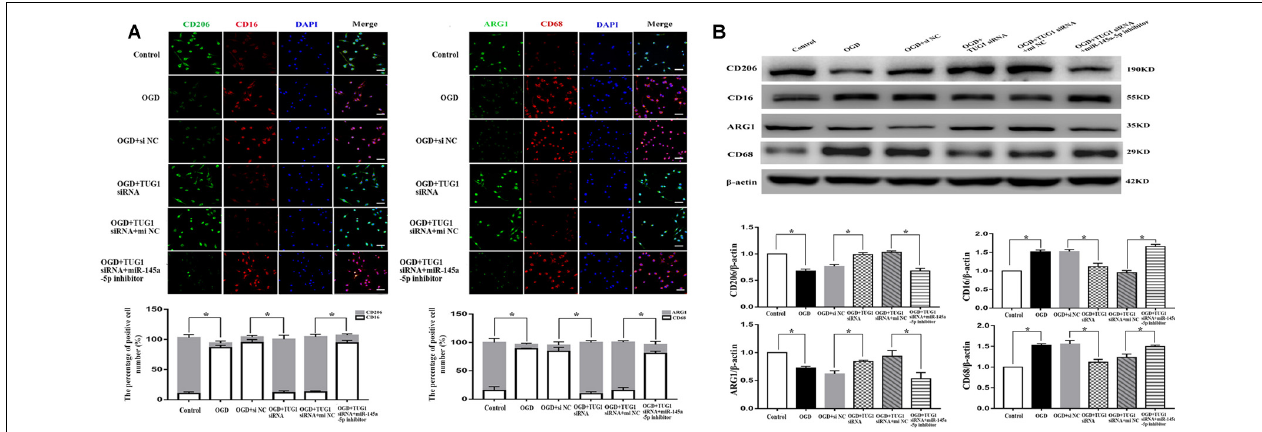
FIGURE 3 | Microglial polarization by immunofluorescence (A) and western blot (B) . TUG1 knockdown increased the number of ARG1 and CD206 positive cells (M2-like phenotype, green) as well as the protein levels, whereas decreased that of CD16 and CD68 positive cells (M1-like phenotype, red) as well as the protein levels after OGD. The effect of TUG1 knockdown on microglial polarization was reversed by miR-145a-5p inhibitor. ∗ P < 0.05 vs. the corresponding control. 400 × . Scale bar = 50 µ m. n = 4.